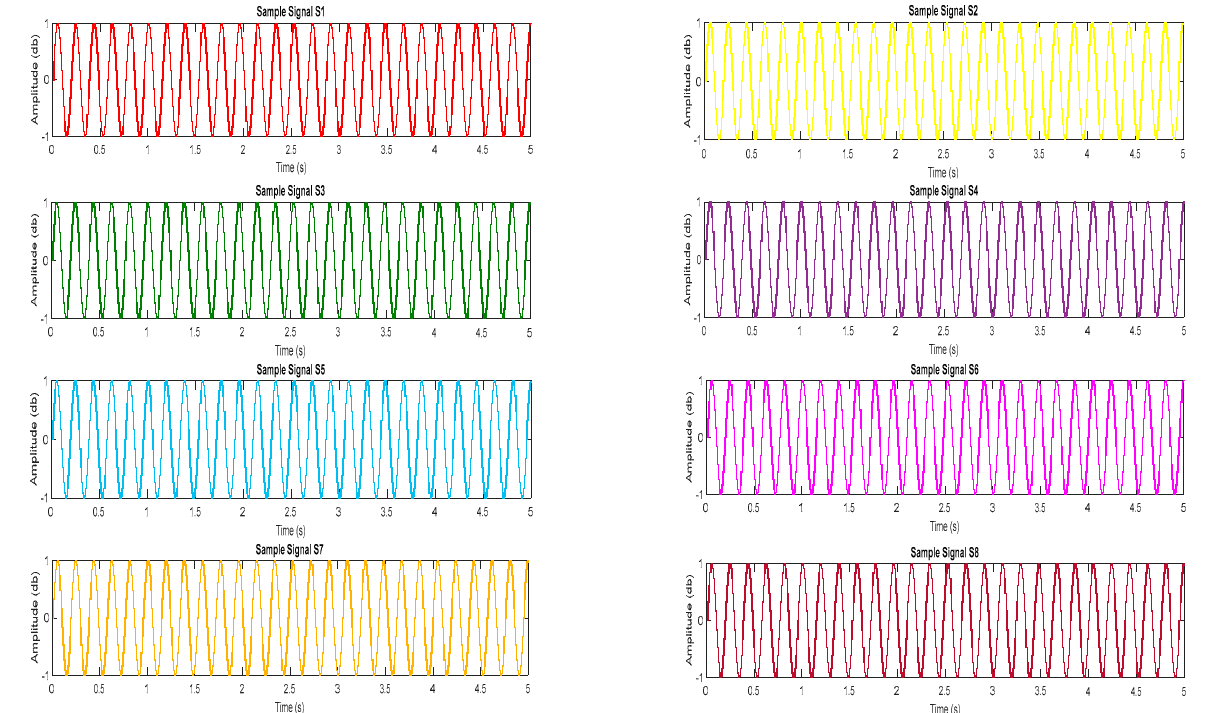
Figure 6. Signals from Eight RFID tags attached on human body performing walking activity.